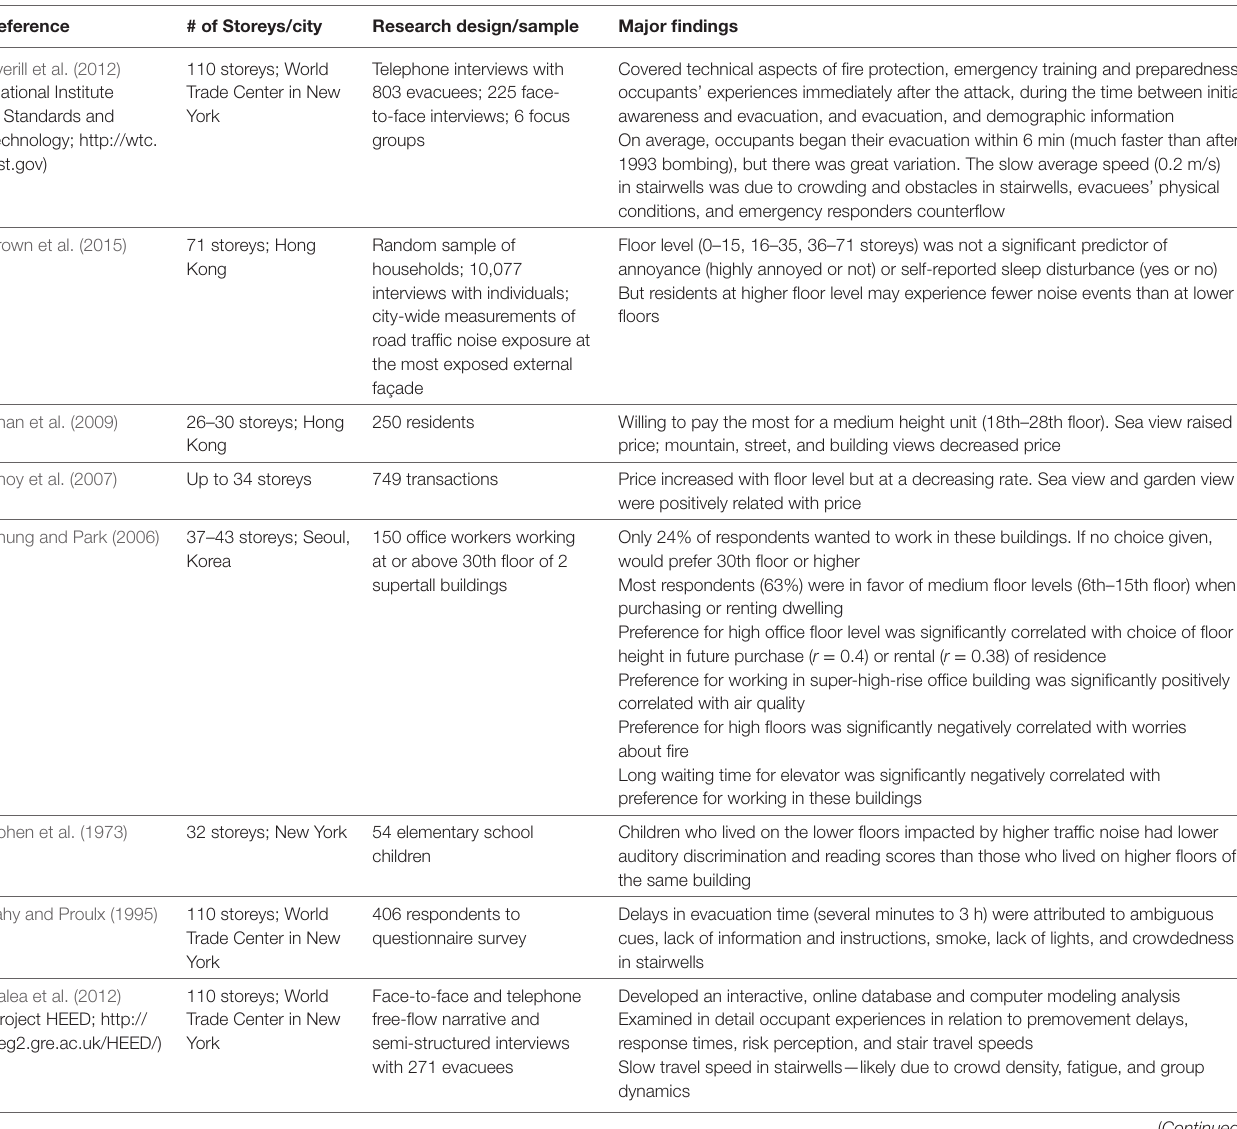
TaBLe 1 | Studies of tall